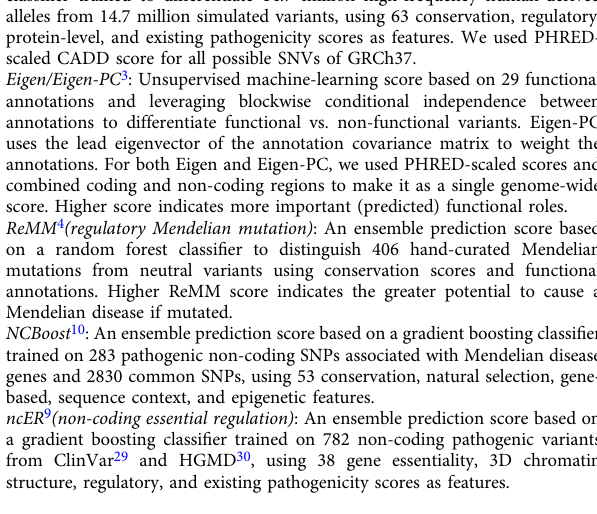
Genome-wide Mendelian disease-derived pathogenicity